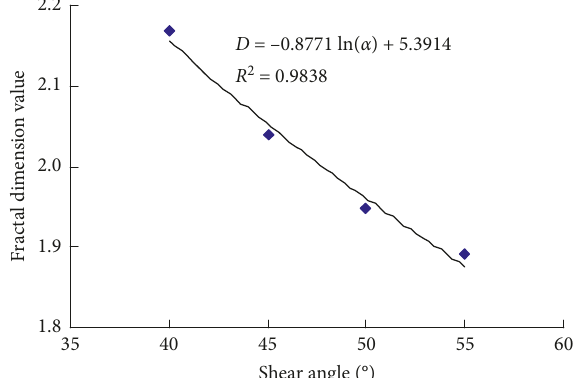
Figure 7: Relationship between fractal the dimension and the shear